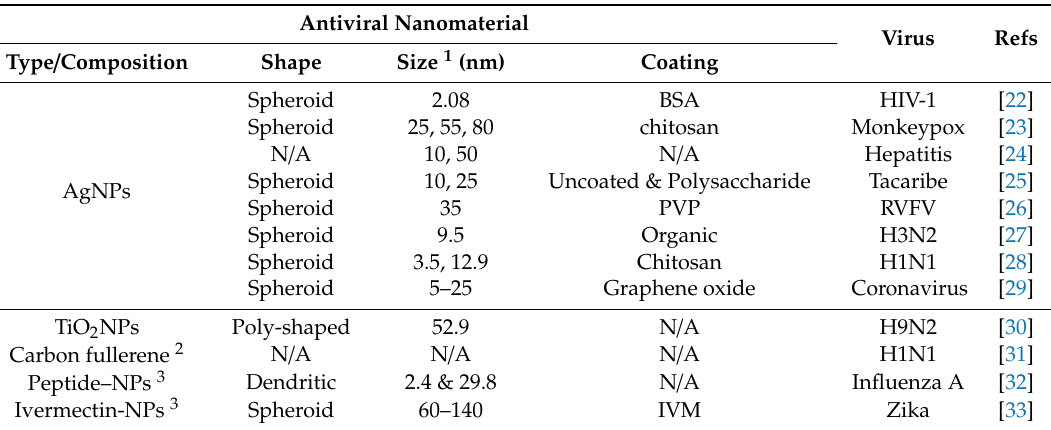
Table 1. A non-exhaustive list of examples of antiviral nanomaterials that inactivate different types of viruses, in preclinical assays in vitro.